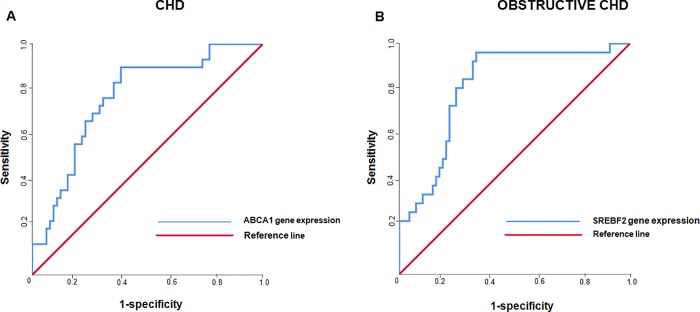
(A) ROC curve analysis generated from the multivariate model for the presence of CHD and ABCA1 gene expression; (B) ROC curve analysis generated from the multivariate model for the presence of obstructive CHD and SREBF2 gene expression.